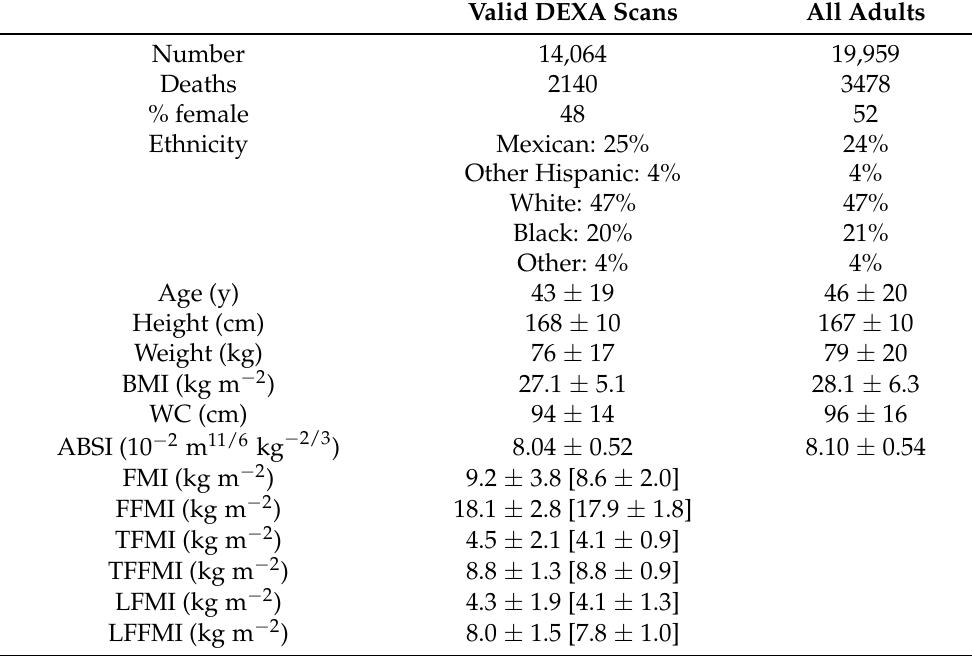
Table 1. NHANES 1999–2006 sample